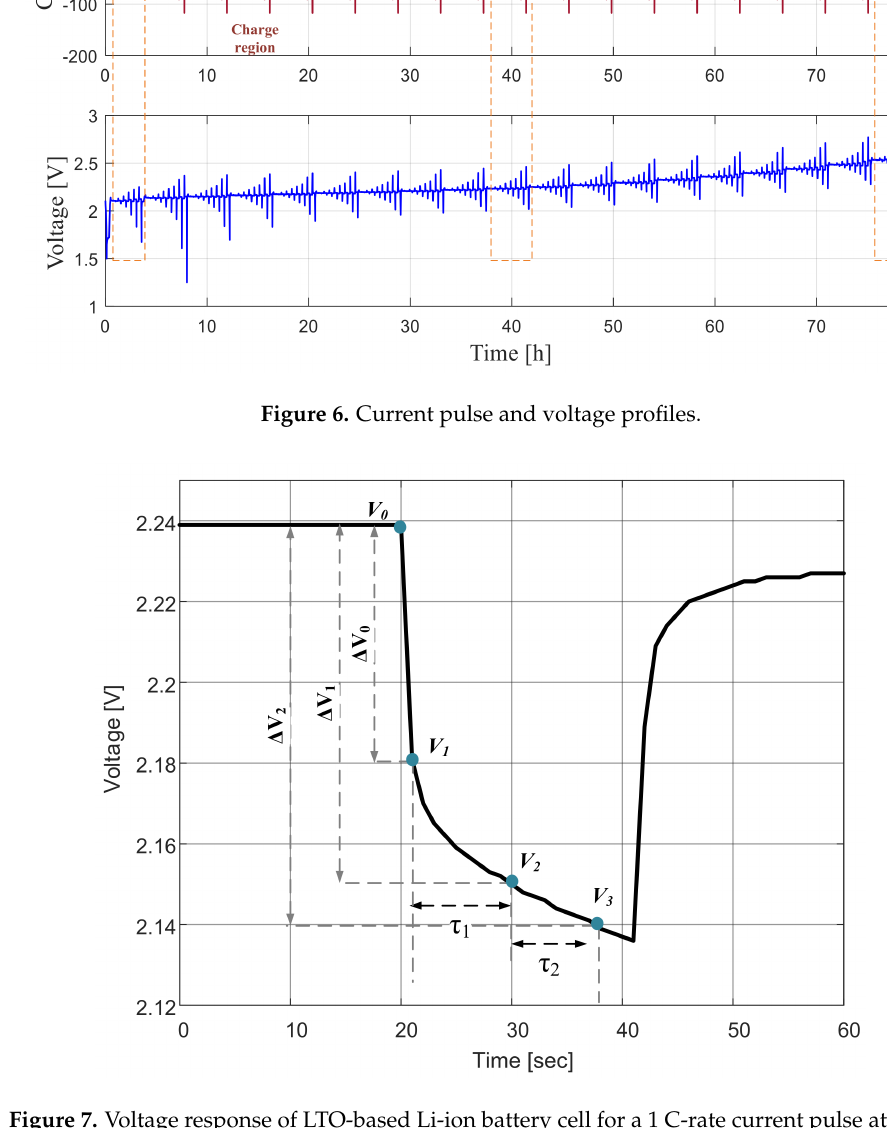
Figure 7. Voltage response of LTO-based Li-ion battery cell for a 1 C-rate current pulse at 25 ◦